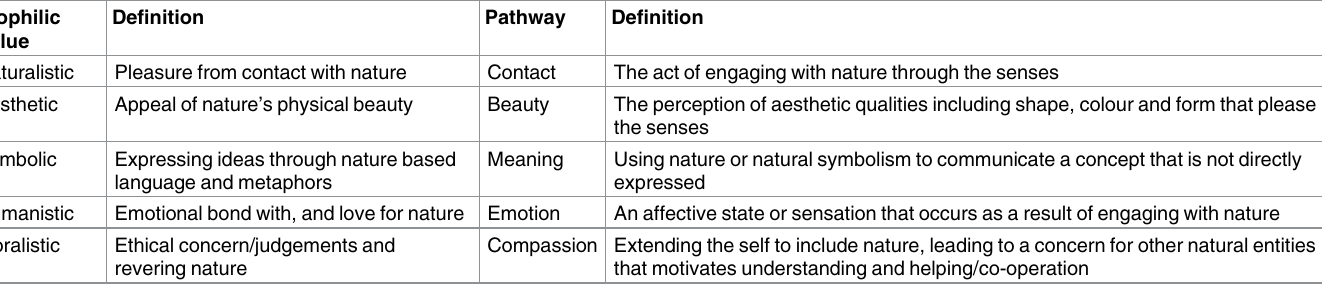
Table 18. A summative matrix of the identified pathways and their corresponding biophilic